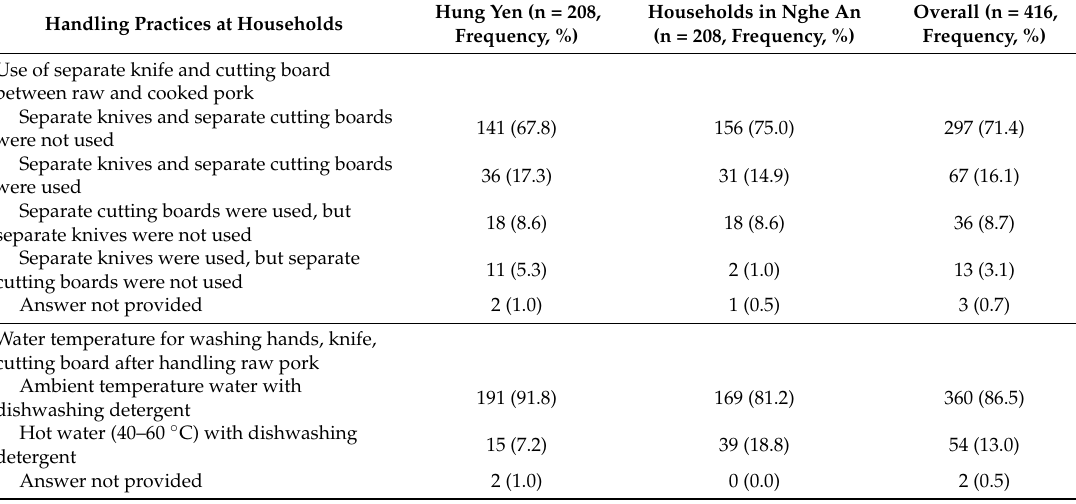
Figure 3. Reduction rate of Salmonella concentration in CFU/g after washing raw pork twice. 3.3. Cross-Contamination of Equipment and Hands with Salmonella from Raw Pork Table 4 shows the proportions of sliced cooked pork, equipment, and hands for which Salmonella was transferred from raw to cooked pork (cross-contamination). Although raw pork was washed twice, cross-contamination with Salmonella from pork to hands, knives and cutting boards was common (78%, 78%, and 100%, respectively). Eight out of nine wash water samples were positive for Salmonella . Table 4. Proportions of cooked pork slice, hands, equipment and wash water on which cross- contamination with Salmonella occurred during the experiments. Type of Sample Samples Cross-Contaminated (n = 9)